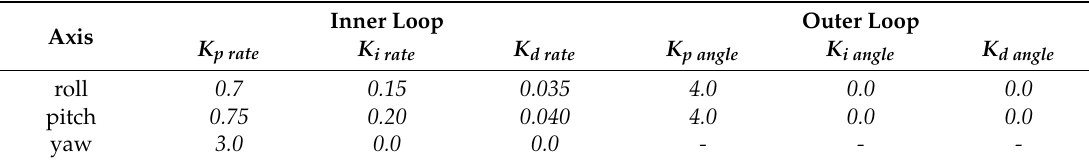
( b ) Figure 23. Hover stability with different Ki values, ( a ) measurement — Ki = 0, ( b ) — measurement — Ki = 0.2. As planned, the final adjustment to the PID gains was conducted between flights based on the